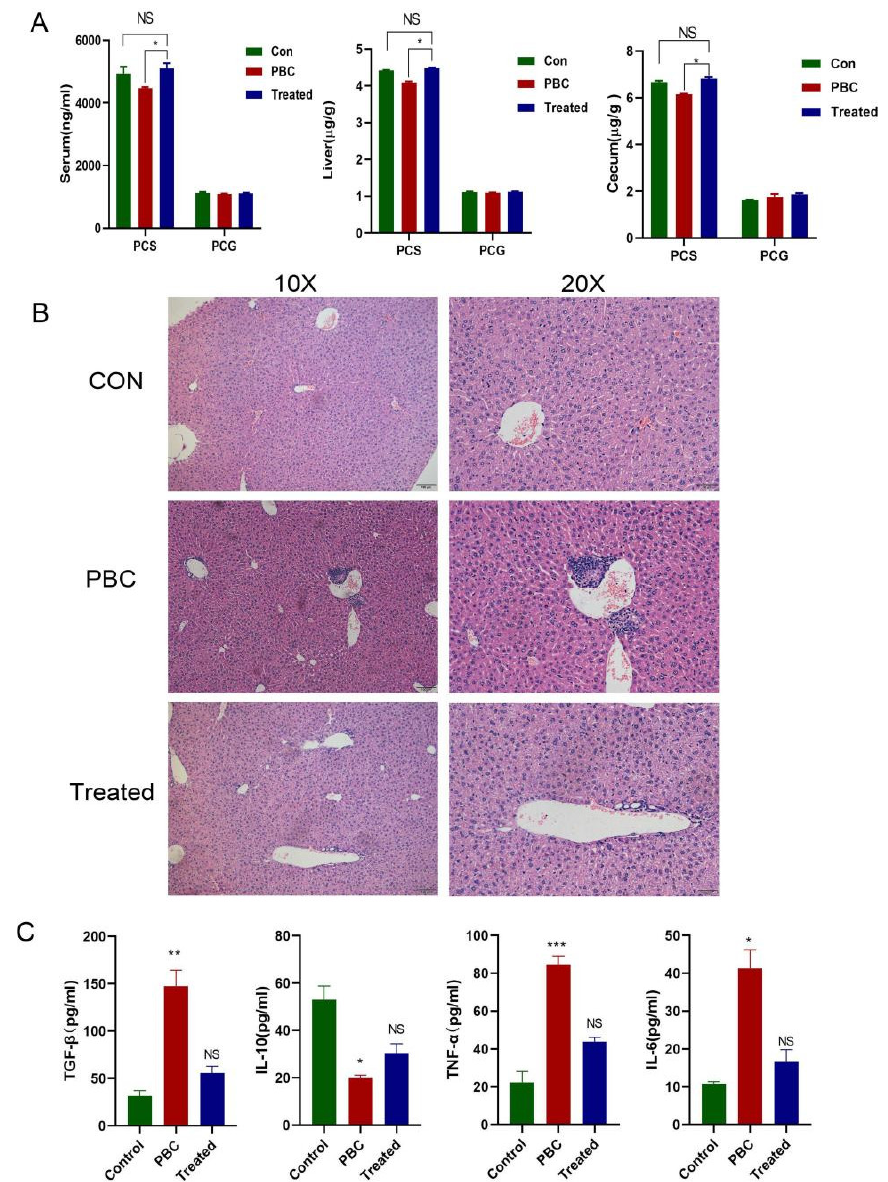
Figure 3. The effect of food-derived PCS on PBC mice. ( A ) A tyrosine-rich diet increased PCS concentrations in serum, liver, and cecum in PBC mice. ( B ) Liver inflammation in PBC mice was partially reduced by food-derived PCS. ( C ) Level of IL-6, IL-10, TNF-α, and TGF-β in serum from each group. PBC model group ( n = 7), normal control group ( n = 10), and PBC tyrosine treatment group ( n = 8). * p < 0.05, ** p < 0.01, and *** p < 0.001. NS: no significance. To confirm the reversal of liver inflammation in PCS-treated PBC mice, we detected mRNA levels of IL-6, TNF-α, IL-10, and CCL3 by PCR in liver tissue from each group of mice (Figure 4A), followed by confirmation of protein levels by western blot (Figure 4B). The results showed that both mRNA and protein levels of inflammatory cytokines were elevated in PBC mice along with decreased levels of anti-inflammatory cytokines, whereas the opposite trend was observed in PCS-treated mice, which was consistent with ELISA results.